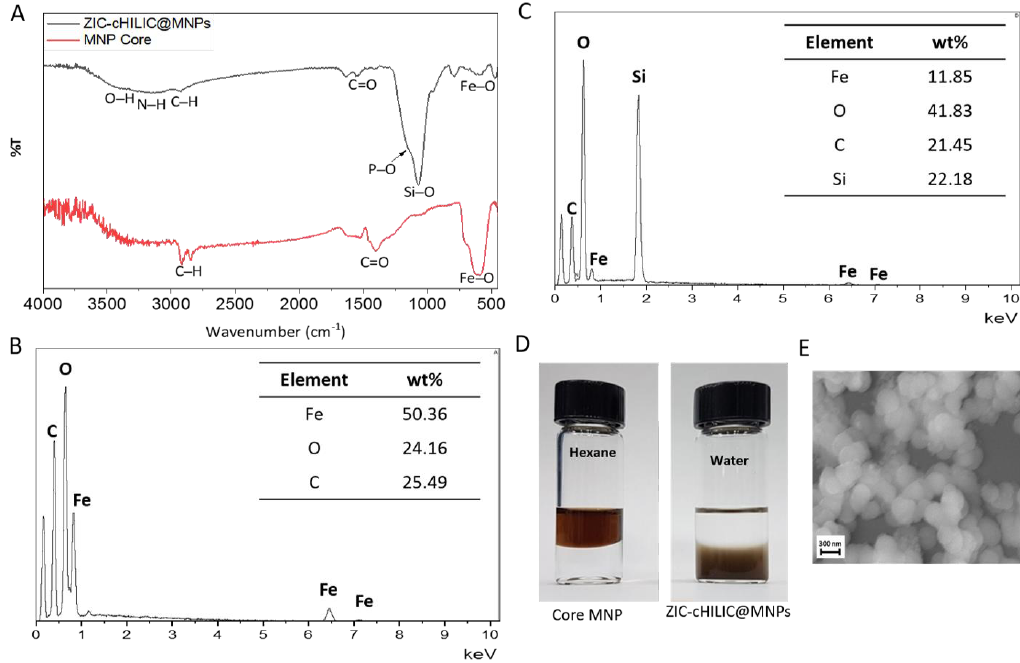
Figure 2. Characterization of ZIC-cHILIC@MNPs. ( A ) FTIR result and, ( B , C ) EDX of core MNPs and ZIC-cHILIC@MNPs, ( D ) polarity test of core MNPs and ZIC-cHILIC@MNPs, respectively. ( E ) FE-SEM image of